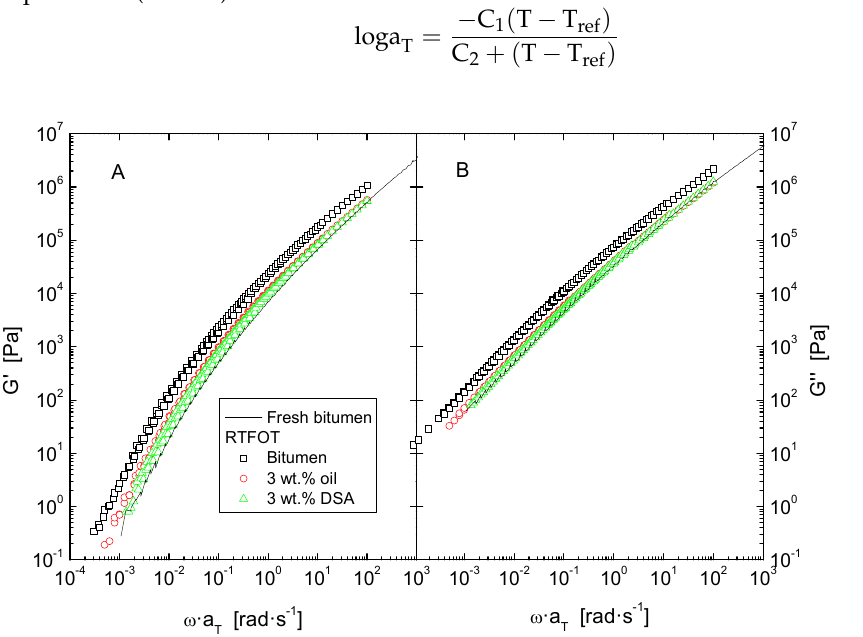
Figure 6. Master curves of storage ( A ) and loss moduli ( B ), at a reference temperature of 30 °C, for neat bitumen and rejuvenated bitumen after ageing by RTFOT.